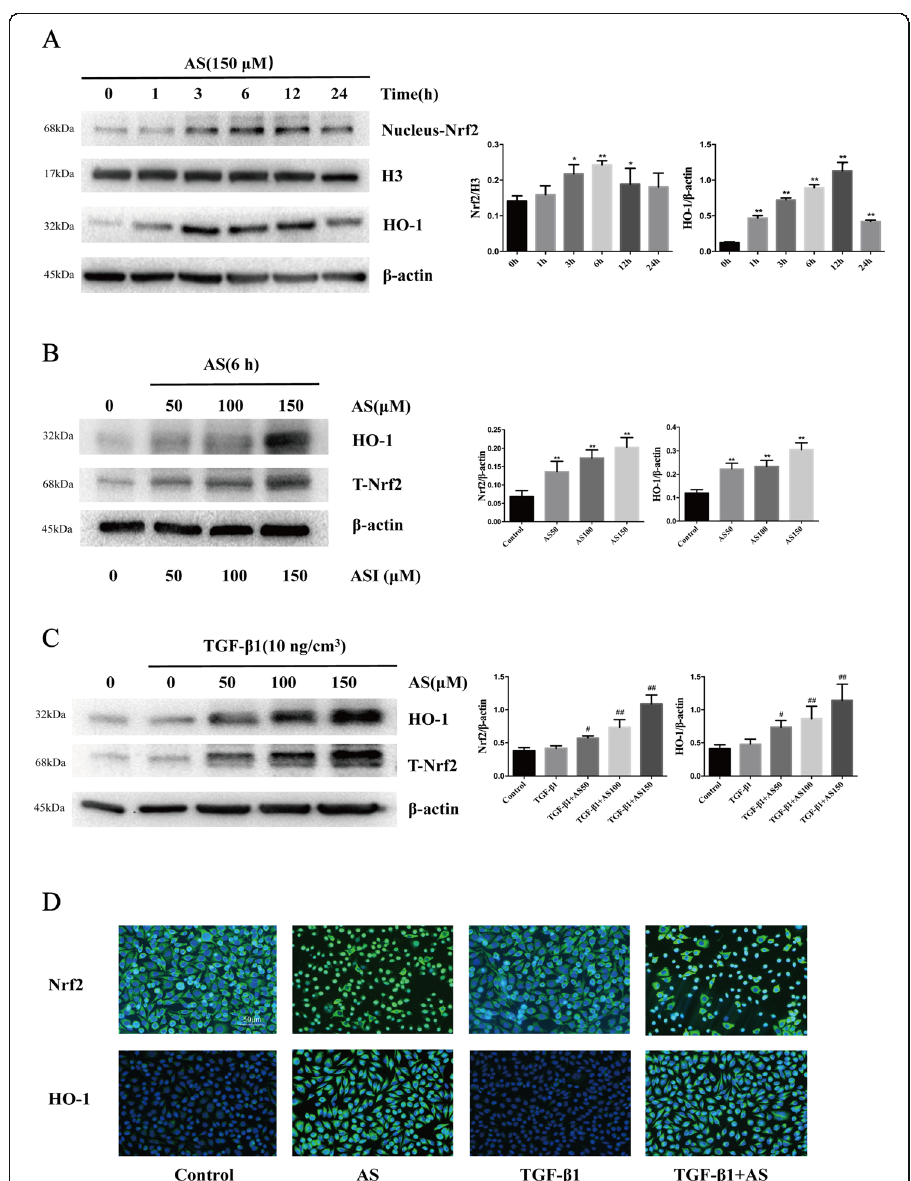
Fig. 6 Effect of asiaticoside on Nrf2 activation in HPMCs. Notes: (A) After asiaticoside (150 μ M) treatment for various times (0, 1, 3, 6, 12, 24 h), the expression of Nrf2 in the nucleus and HO-1 expression were detected by immunoblotting. Histone H3 and β -actin were used as the loading controls for the nucleus and cytosol, respectively. (B) After treatment with various doses of asiaticoside (0, 50, 100, 150 μ M) for 6 h, Nrf2 and HO-1 expression were detected by immunoblotting. (C) After treated with asiaticoside at various concentrations (0, 50, 100, 150 μ M) and TGF- β 1 (10 ng/cm 3 ) treatment for 6 h, Nrf2 and HO-1 expression were detected by immunoblotting. β -actin was used as a loading control. Densitometric analysis of the expression of Nrf2 and HO-1 are shown as unique figures. Data are expressed as the mean ± SEM, * p < 0.05 vs. control, ** p < 0.01 vs. control; #p < 0.05 vs. TGF- β 1 treatment; ##p < 0.01 vs. TGF- β 1 treatment. (D) Immunofluorescence assays were performed to observe the subcellular translocation of Nrf2. Nrf2 expression in the membrane, cytoplasm and nucleus were visualized based on the green fluorescent signal obtained by fluorescence microscopy (scale bar = 50 μ m). Abbreviations: AS, asiaticoside; TGF- β 1, transforming growth factor- β 1; Nrf2, nuclear factor erythroid-2-related factor 2; HO-1, heme oxygenase